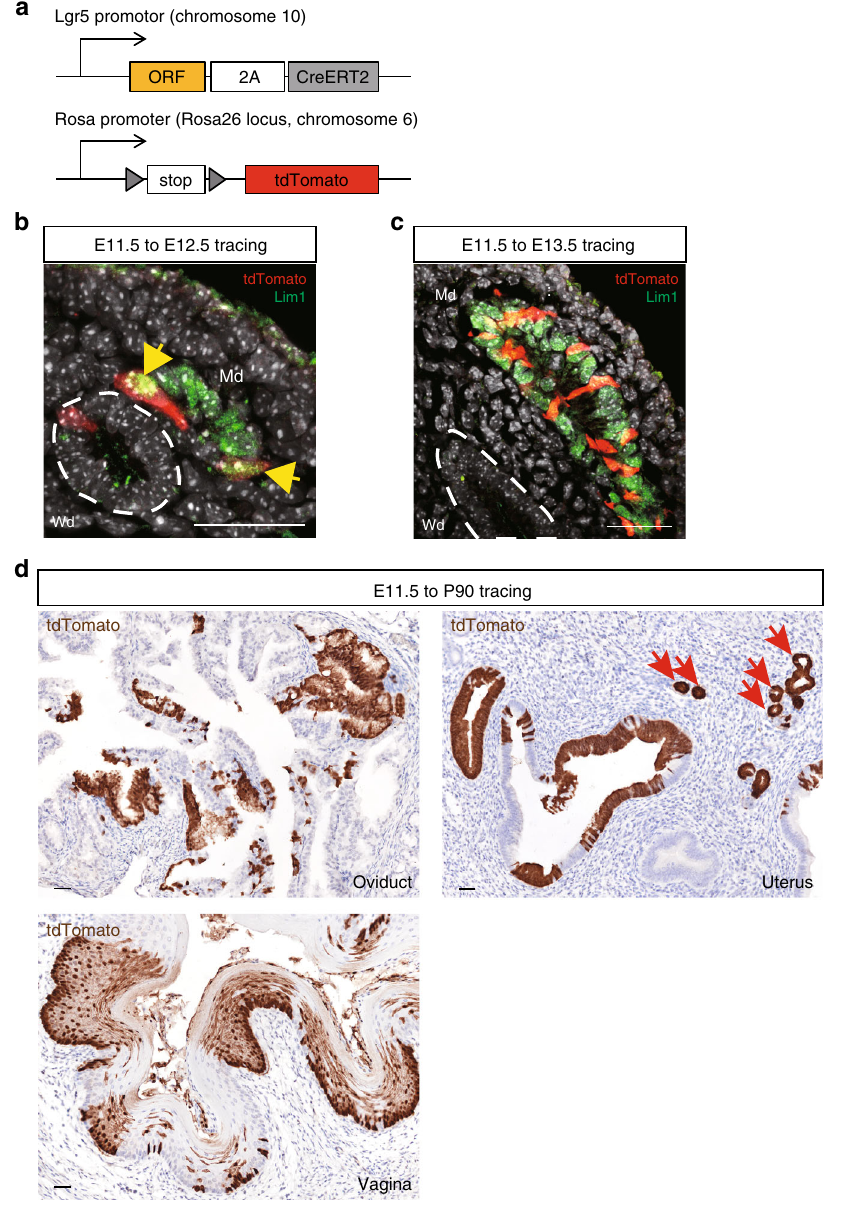
Fig. 2 Embryonic Lgr5 + populations are stem/progenitor cells for the female reproductive tract. a The Lgr5-2A-CreERT2; R26-tdTomato mouse model employed to trace Lgr5 + cell-derived progeny. b , c Short-term lineage tracing in the developing reproductive tract induced at E11.5. Co-IF for tdTomato and Lim1 on E12.5 genital ducts shows tdTom + cells in both the Lim1 + Md and the adjacent Lim1 − Wd cells (white dashed lines) ( b ) and reveals expansion of Lim1 + /tdTom + tracing exclusively within the Md at E13.5 ( c ). Yellow arrows indicate single tdTom + cells at E12.5. d Long-term lineage tracing in the female reproductive tract induced from E11.5 to P90. Immunostaining for tdTomato reveals a major contribution of embryonic Lgr5 + cells to the epithelia of the adult oviduct, uterus and vagina. Red arrows indicate glandular cells. Scale bars, 50 μ m. All images are representative of three independent development and maintenance of both the endometrial LE and (Supplementary Fig. 4a – e), and traced Lgr5 + cell-derived pro- GE (Fig. 4f, h). In contrast, when tracing was initiated from P14, geny to various ages. When tracing was initiated at P7, the the tdTomato reporter was predominantly activated at the tips tdTomato reporter gene was activated in both LE and developing of developing GE (Fig. 4d; 2 days post injection), re fl ecting the GE, consistent with the location of endogenous Lgr5 + cells at this stage (Fig. 4a; 1 day post injection). One week later, multiple endogenous distribution of Lgr5 high cells at this stage. At later contiguous tdTom + tracing units had expanded deep into the time points, expanding tracing units were largely Foxa2 + , con- outer stromal area as endometrial glands developed (Fig. 4b; sistent with a restricted contribution of P14 Lgr5 high cells to GE development and maintenance (Fig. 4e, g, h and Supplementary 7 days post injection). At P56, extensive dTom + tracing units were readily evident throughout both the LE and GE endo- Fig. 4f). These Lgr5 lineage-tracing data collectively indicate that metrial compartments (Fig. 4c). Approximately 10% of the P7- endometrial Lgr5 + cells in prepubertal uterus are initially functioning as stem/progenitor cells responsible for the devel- P56 dTom + cells co-expressed Foxa2 , a speci fi c marker of GE 20 , indicating a long-term contribution of P7 Lgr5 + cells to the opment of both the LE and GE, but gradually convert to being a